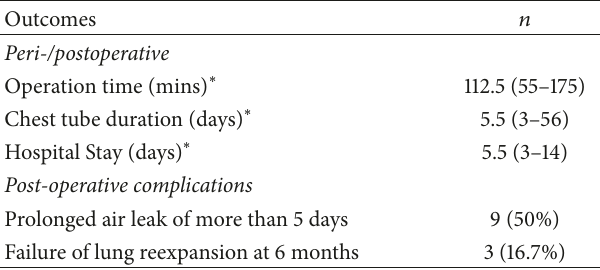
Table 4: Comparison of perioperative and postoperative outcomes. Outcomes